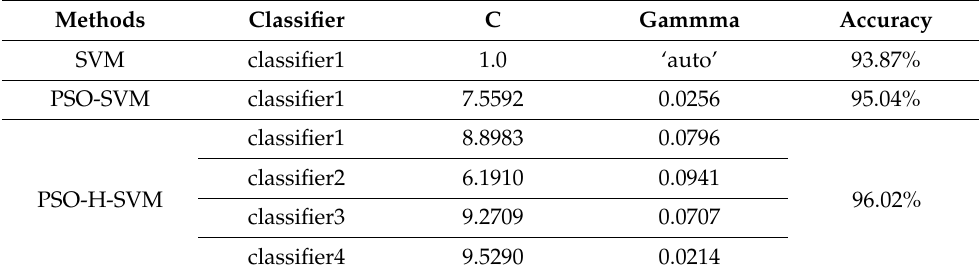
Table 2. Hyperparameter values and accuracy of each algorithm.